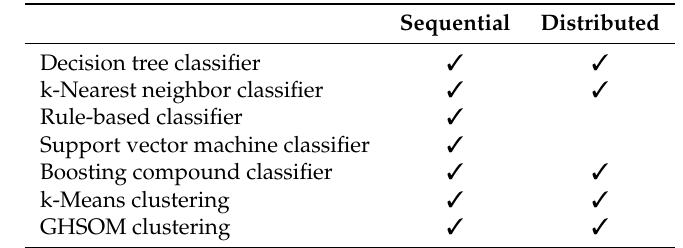
Table 1. Overview of currently implemented supervised and unsupervised models in Java bag of words library